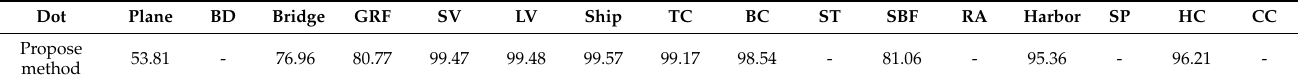
Table 2. The accuracy indexes of the dot of each type of object.